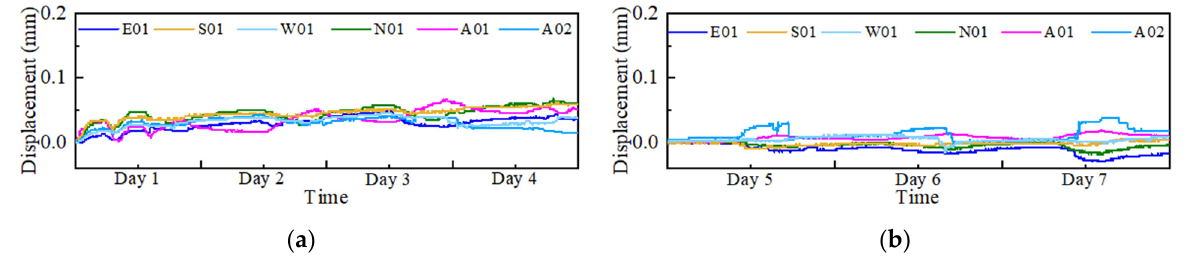
Figure 8. Crack displacements obtained from the displacement transducers: ( a ) westward; ( b ) north- ward.